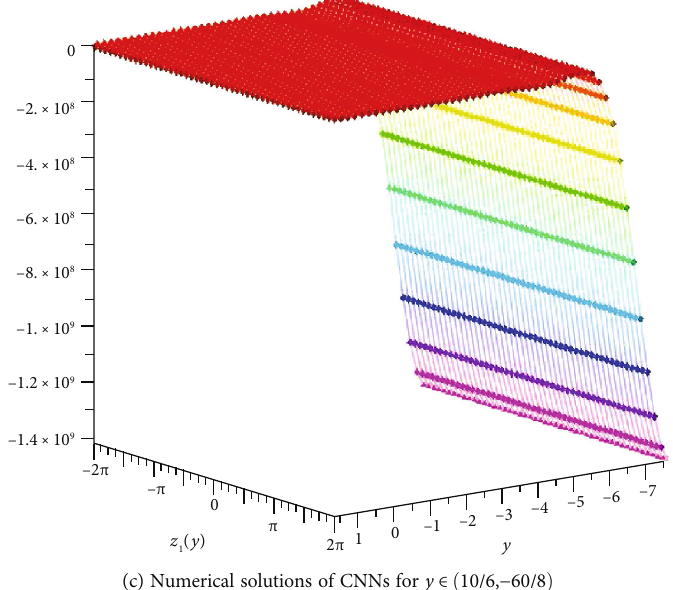
Figure 3: Graphs related to numerical solutions of CNNs (1) for di ff erent